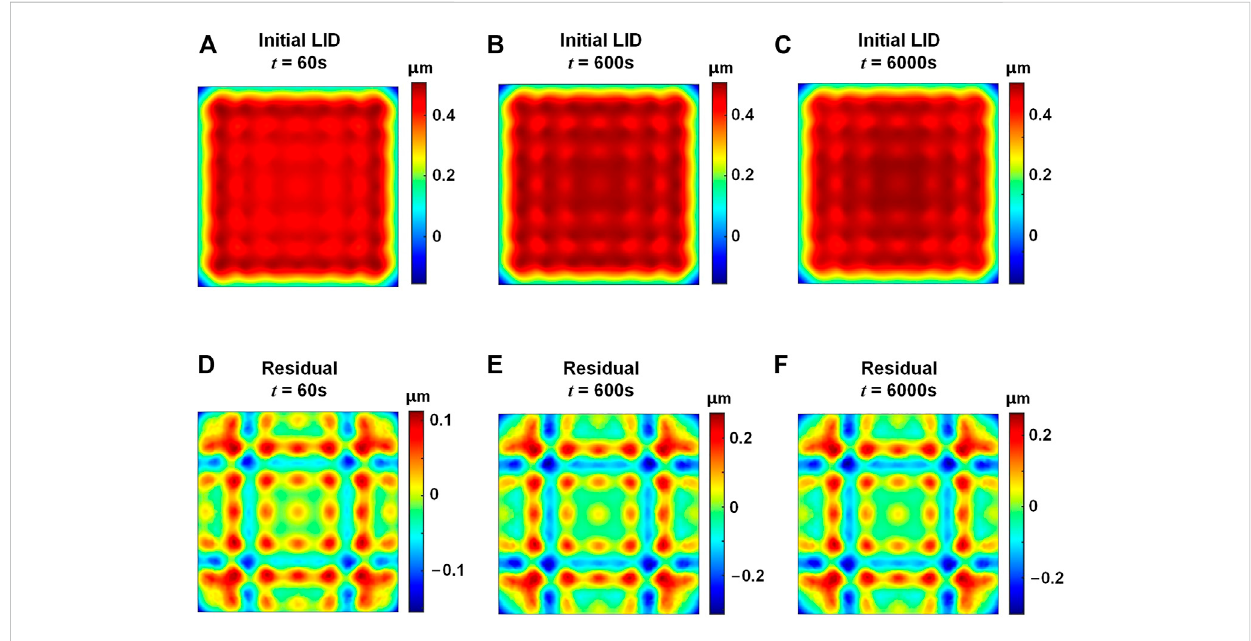
FIGURE 8 LID of the ADM under laser irradiation. (A – C) LID, t = 60 s, 600 s, and 6000 s, respectively. (D – F) Self-correction residuals, t = 60 s, 600 s, and 6000 s,